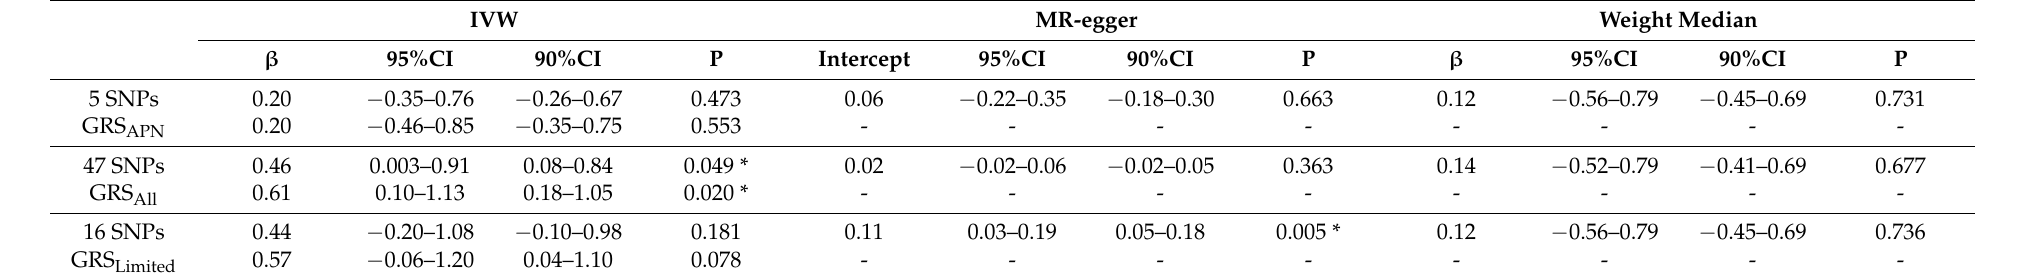
Table 2. The association of adiponectin on diabetic retinopathy risk using Mendelian